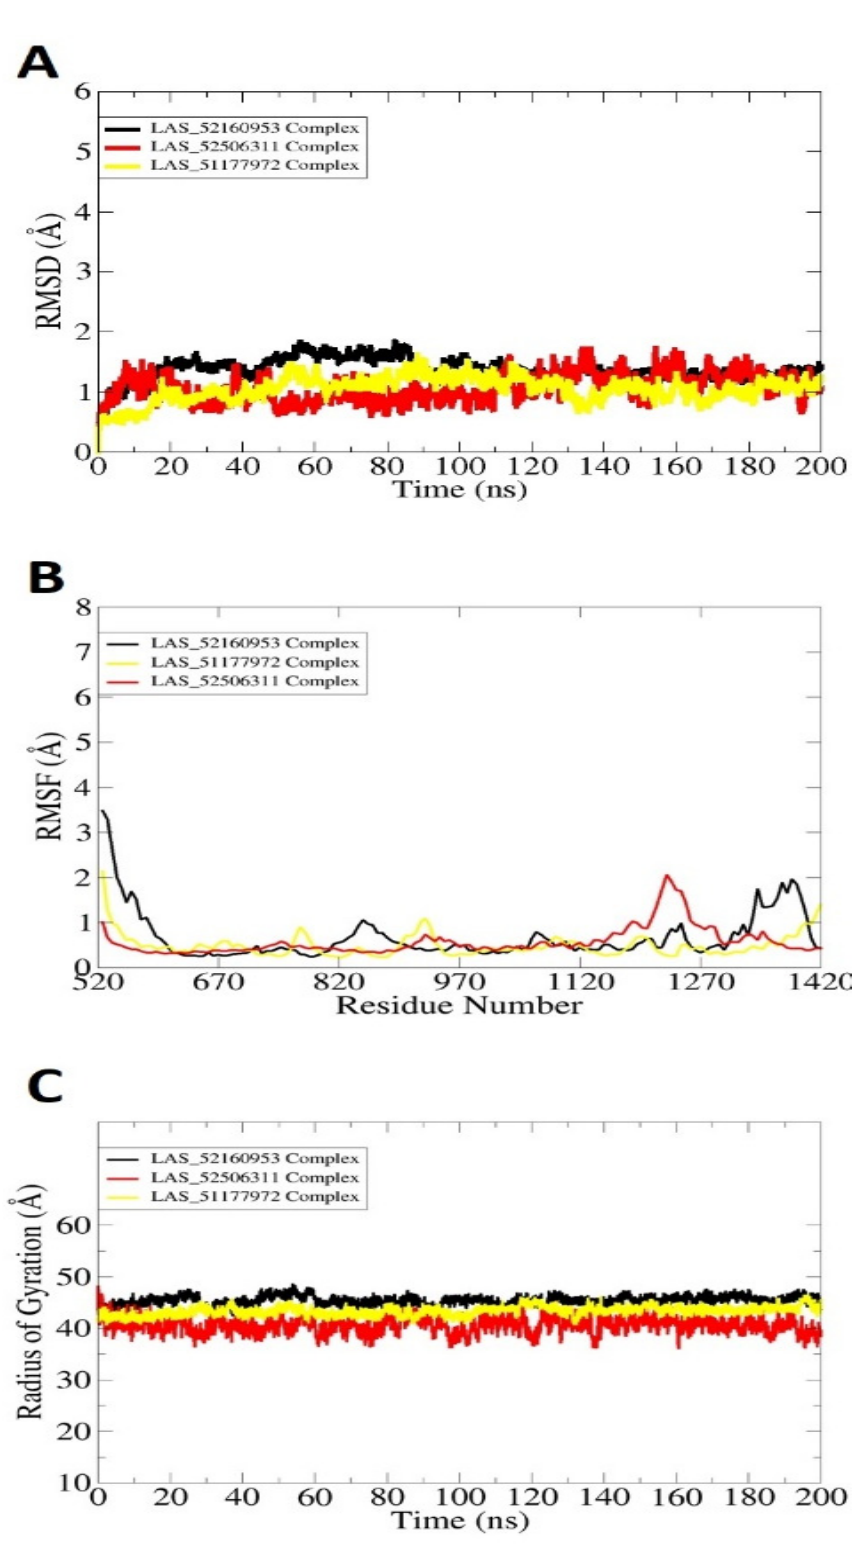
Figure 2. Molecular dynamic simulation analysis done using the CPPTRAJ module. ( A ) RMSD, ( B ) RMSF, and ( C ) RoG. All the analyses are plotted versus ångström.